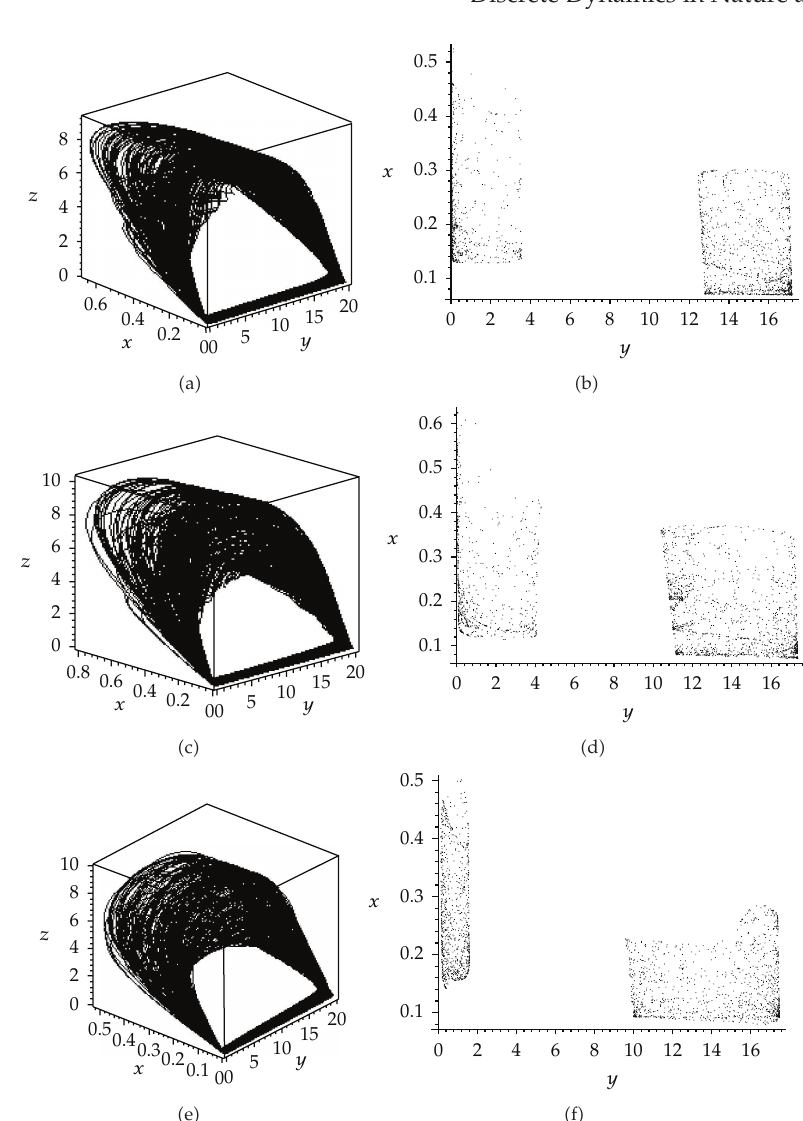
Figure 5: (cid:7) a (cid:8) Strange attractor with ϕ (cid:6) 0, ω (cid:6) 0 . 26; (cid:7) b (cid:8) Poincar´e section of attractor (cid:7) a (cid:8) ; (cid:7) c (cid:8) strange attractor with ϕ (cid:6) (cid:7) π/ 2 (cid:8) , ω (cid:6) 0 . 26; (cid:7) d (cid:8) Poincar´e section of attractor (cid:7) c (cid:8) ; (cid:7) e (cid:8) strange attractor with ϕ (cid:6) π , ω (cid:6) 0 . 26; (cid:7) f (cid:8) Poincar´e section of attractor (cid:7) e (cid:8) , showing the values of the states x and y in the plane z (cid:6)